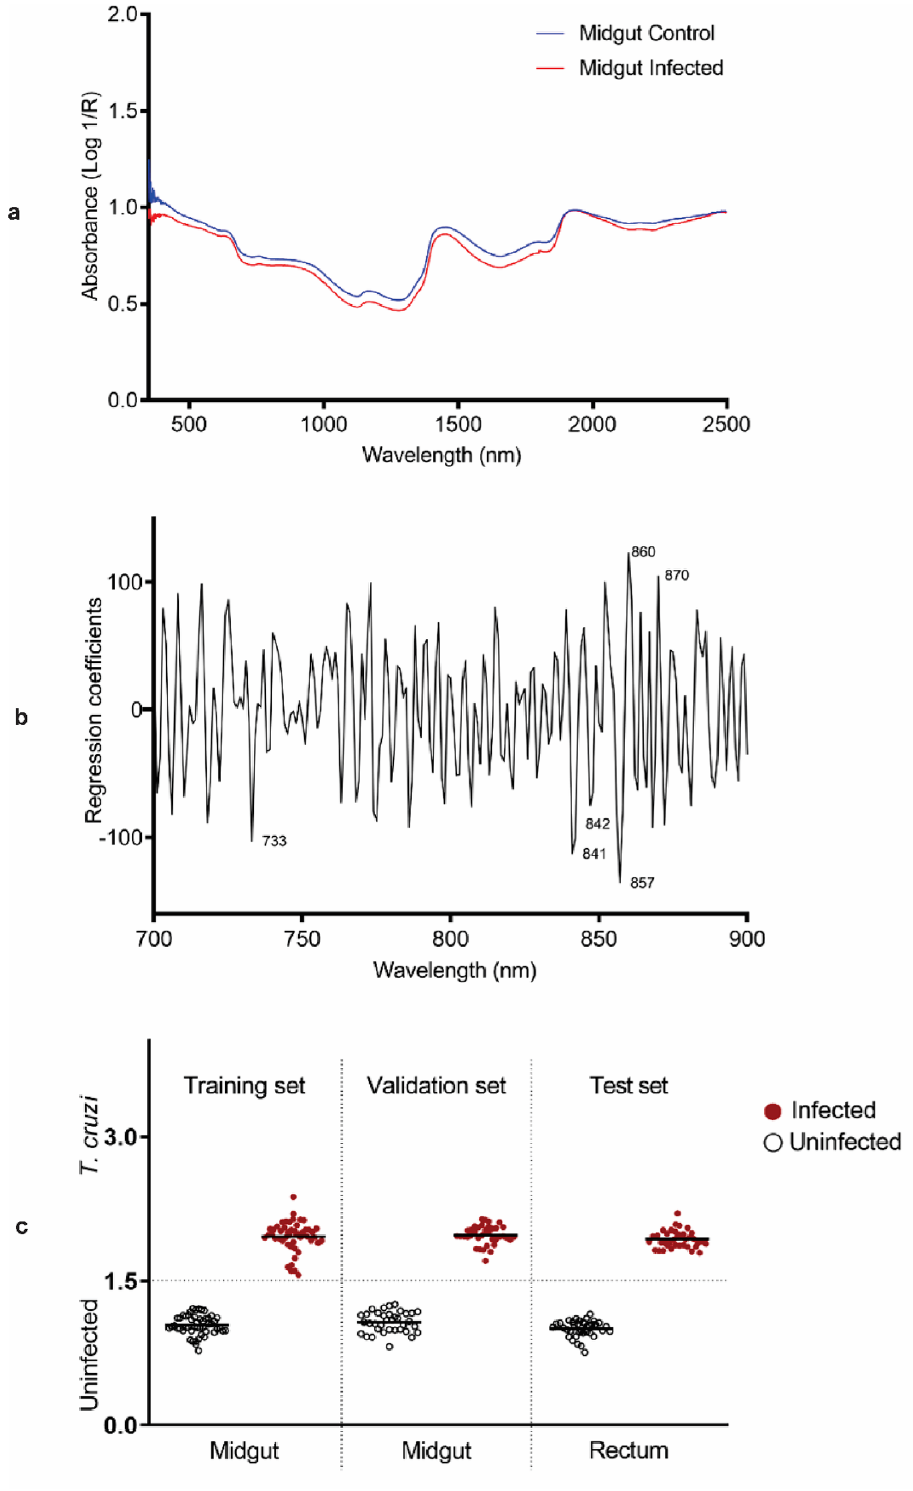
Figure 1. Summary of NIRS data regarding T. infestans midgut. ( a ) Average NIR spectra in the 350–2500 nm region from T. cruzi -infected and uninfected triatomine midguts. ( b ) Regression coefficients using six factors in the PLS model based on the NIR spectra in the 700–900-nm region for differentiating T. cruzi -infected from uninfected samples. ( c ) NIRS differentiation of T. cruzi -infected and uninfected triatomines, using leave-one-out cross-validation analysis (training set), prediction of the spectra from the midgut for samples that were excluded from the model (validation set) and prediction of spectra that were collected from the rectum (test set). Each circle represents an individual insect; infection status confirmed by PCR is indicated by red (infected) or empty (uninfected) circles. The lines indicate the mean prediction value for each group. The vertical axis indicates infection status as predicted by NIRS and was drawn by plotting the actual constituent values (1 = uninfected and 2 = infected), with the dotted line indicating the classification cut off point